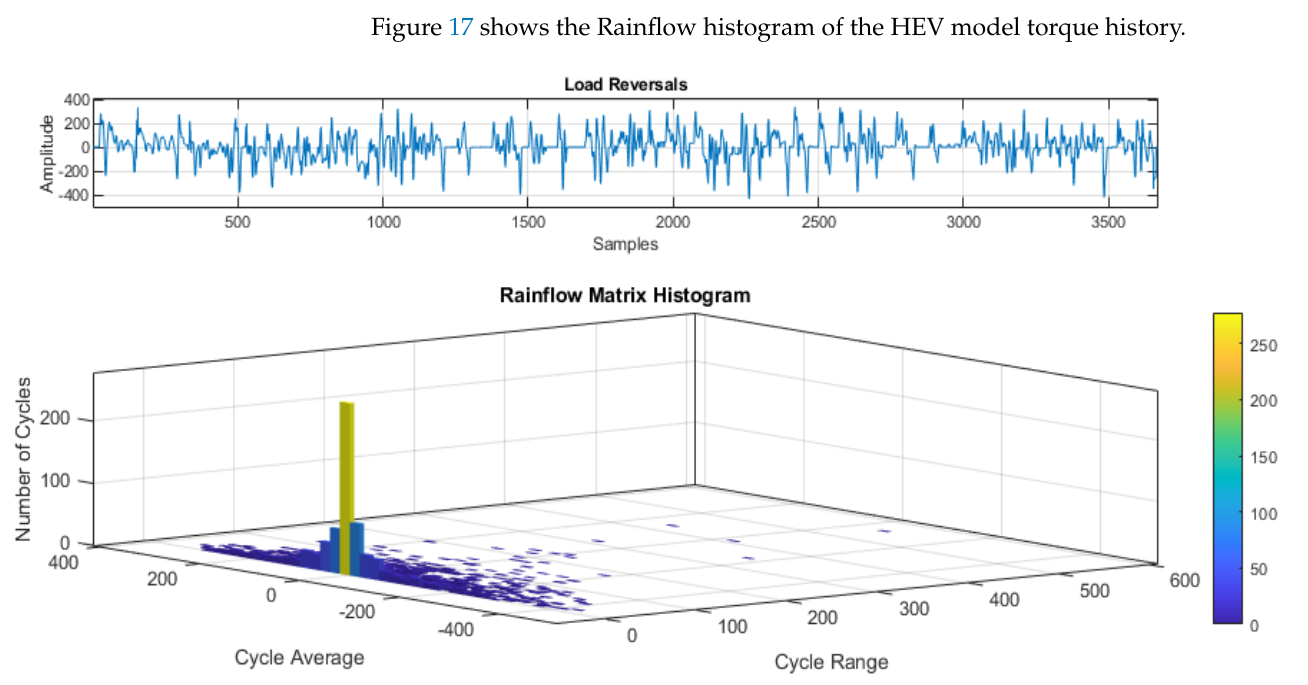
Table 6. First ten load histories from Rainflow method counting (HEV model).